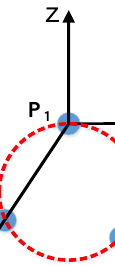
Figure 4. Construction of ECS.